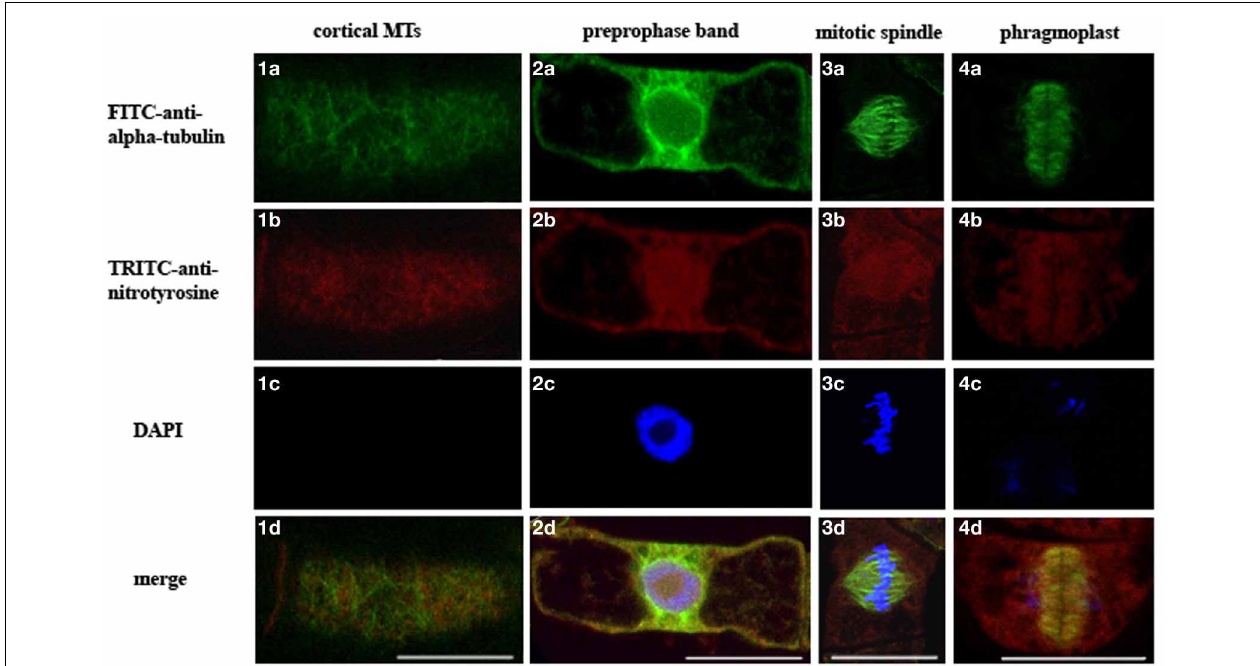
signal), (b) anti-3-NO 2 -Tyr (red signal) (c) DAPI staining (blue signal) (d) merge of images (a–c) . Types of MTs arrays: (1) cortical MTs; (2) preprophase band; (3) mitotic spindle; (4) phragmoplast. Bar = 20 μ m.